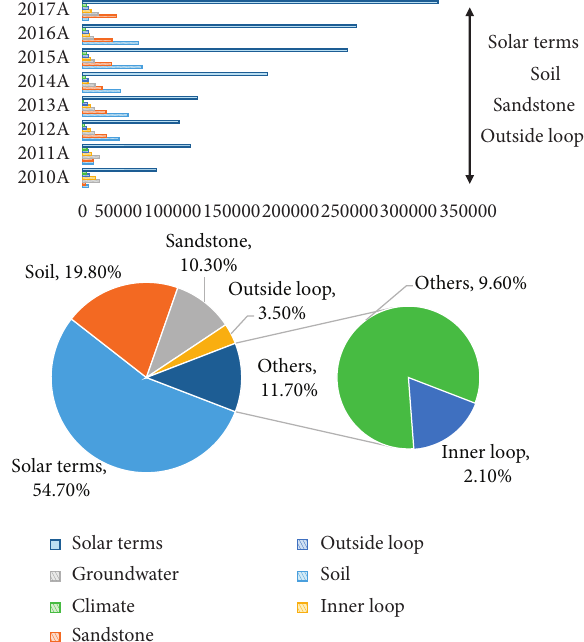
Figure 2: Changes in key parameters in the Biliu River